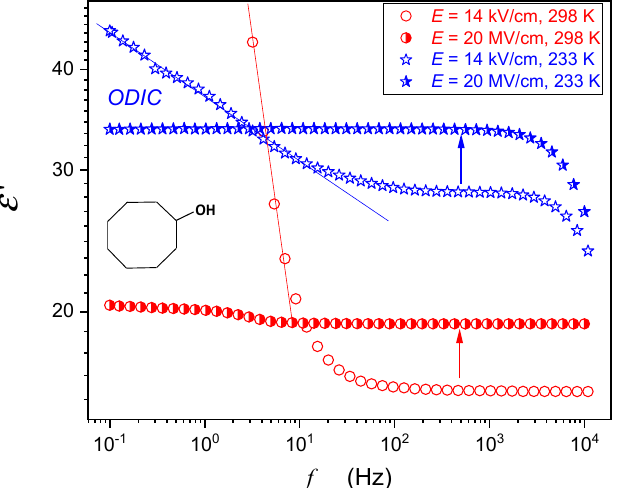
Figure 6. The real part of dielectric permittivity ( 𝜀′ ) determined under the weak and the strong electric field in the (isotropic) liquid (red, circles) and the plastic crystal ODIC phase (blue, stars) in cyclooctanol. Horizontal parts in the plot yield dielectric constant 𝜀 related static domain. The schematic sketch of cyclooctanol’s structure is also shown.